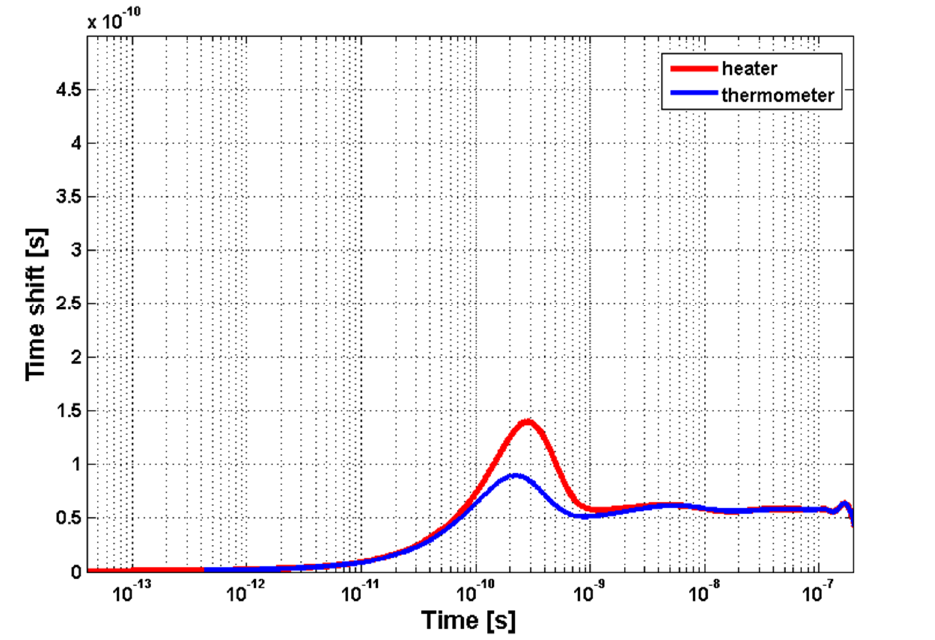
Figure 5. Time shifts over the time for temperature rises in heat source and temperature sensor (excluding investigation in Section 2.4).